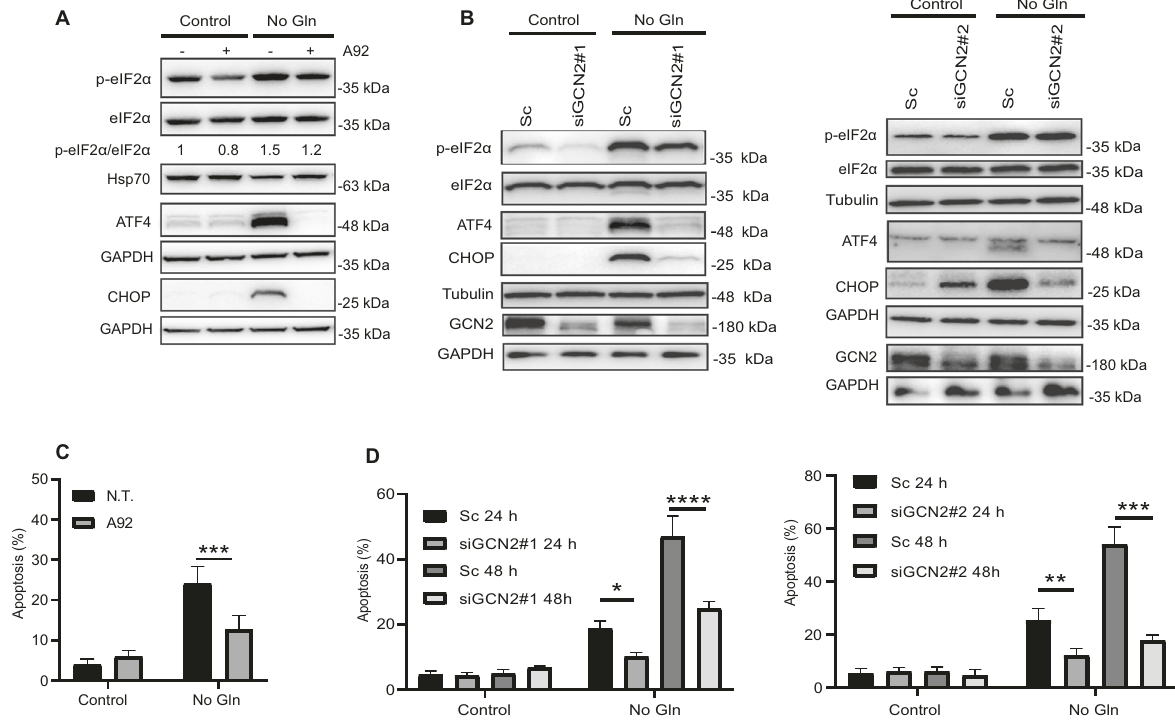
Fig. 2 GCN2 is playing a pro-apoptotic role in cell death induced by glutamine deprivation. A HCT116 cells were cultured for 15 h in the presence or absence of glutamine, with or without 1 µM A92. Western blotting was performed to examine eIF2- α phosphorylation, eIF2- α , ATF4, and CHOP levels. Levels of phosphorylated eIF2- α relative to total eIF2- α protein were quanti fi ed by ImageQuant TL analysis software (Cytiva, USA). GAPDH was used as protein-loading control. B HCT116 cells were transfected for 48 h with either a Scrambled oligonucleotide (Sc) or two different siRNAs targeting GCN2 (siGCN2#1 and #2). After transfection, cells were incubated for 24 h in complete or glutamine- depleted medium and levels of eIF2 α phosphorylation, eIF2 α , GCN2, ATF4 and CHOP were assessed by Western blotting. C HCT116 cells were incubated for 24 h in medium with or without glutamine in the presence or absence of 1 µM A92 and apoptosis assessed as described in “ Materials and methods ” section. D HCT116 cells were transfected for 48 h as described in B . After transfection, cells were incubated for 24 or 48 h in complete or glutamine-depleted medium and apoptosis was then assessed. In C and D , data are presented as mean ± SD from at least three independent experiments. * P < 0.05; ** P < 0.01; *** P < 0.001; **** P < 0.0001; two-way ANOVA test. Tukey ’ s multiple comparison